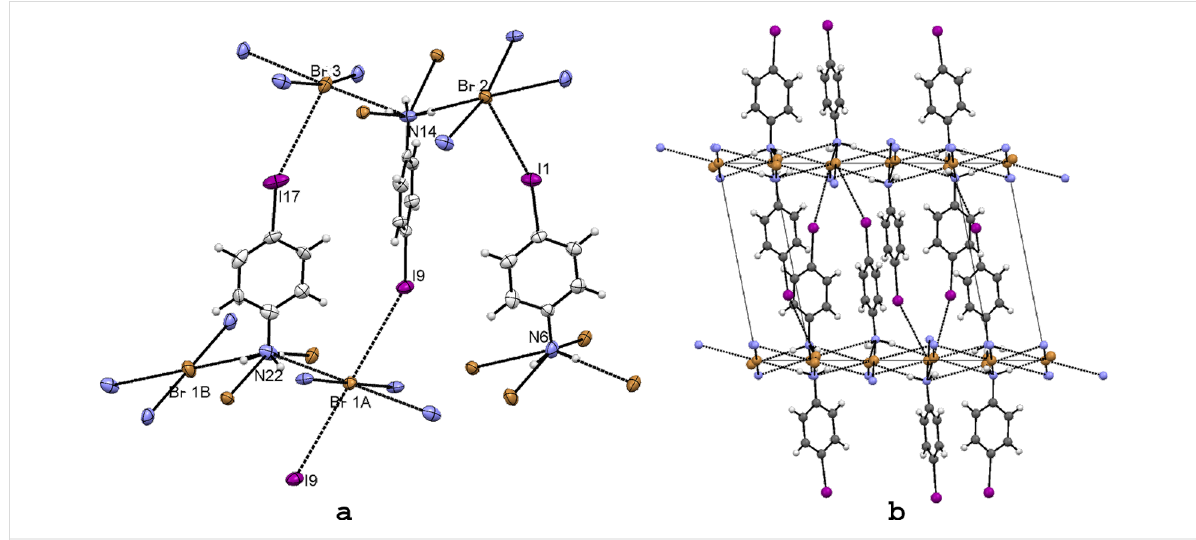
Figure 3: X-ray structure of 4-IPhNH 3 Br ( 5 ) with selected numbering scheme (a) and the packing scheme viewed down the a axis (b). Thermal ellips- oids are drawn at the 50% probability level. Hydrogen and halogen bonds are shown in dotted lines.